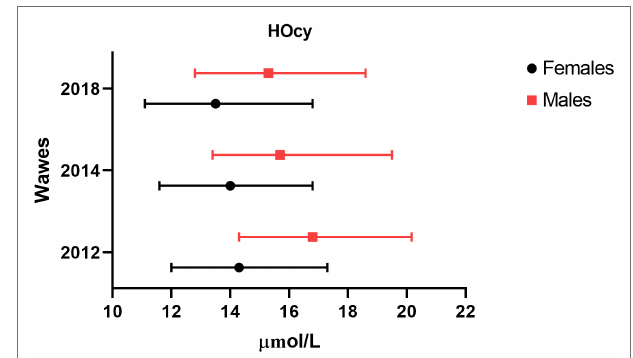
FIGURE 2 | Sex difference in plasma HOcy concentration ( μ mol/l). Median and interquartile ranges of HOcy reported by sex. All differences were statistically significant ( p < 0.01; Mann–Whitney